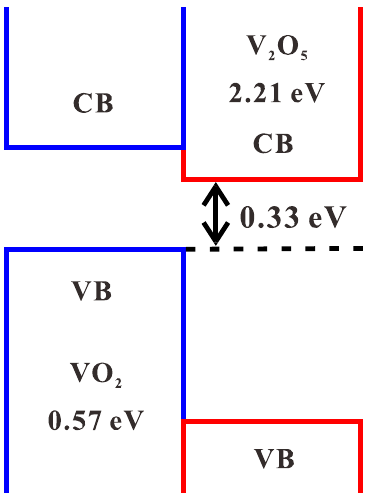
Figure 11: Energy diagrams of VO 2 /V 2 O 5 core – shell heterostructures.